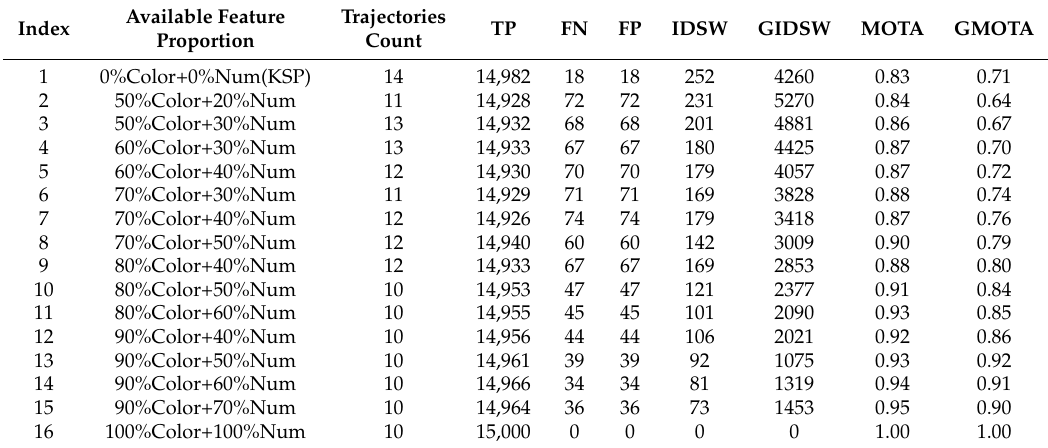
Table 1. The list of tracking performance under different available proportion of the jersey color and jersey number based on KSP-AF in APIDIS